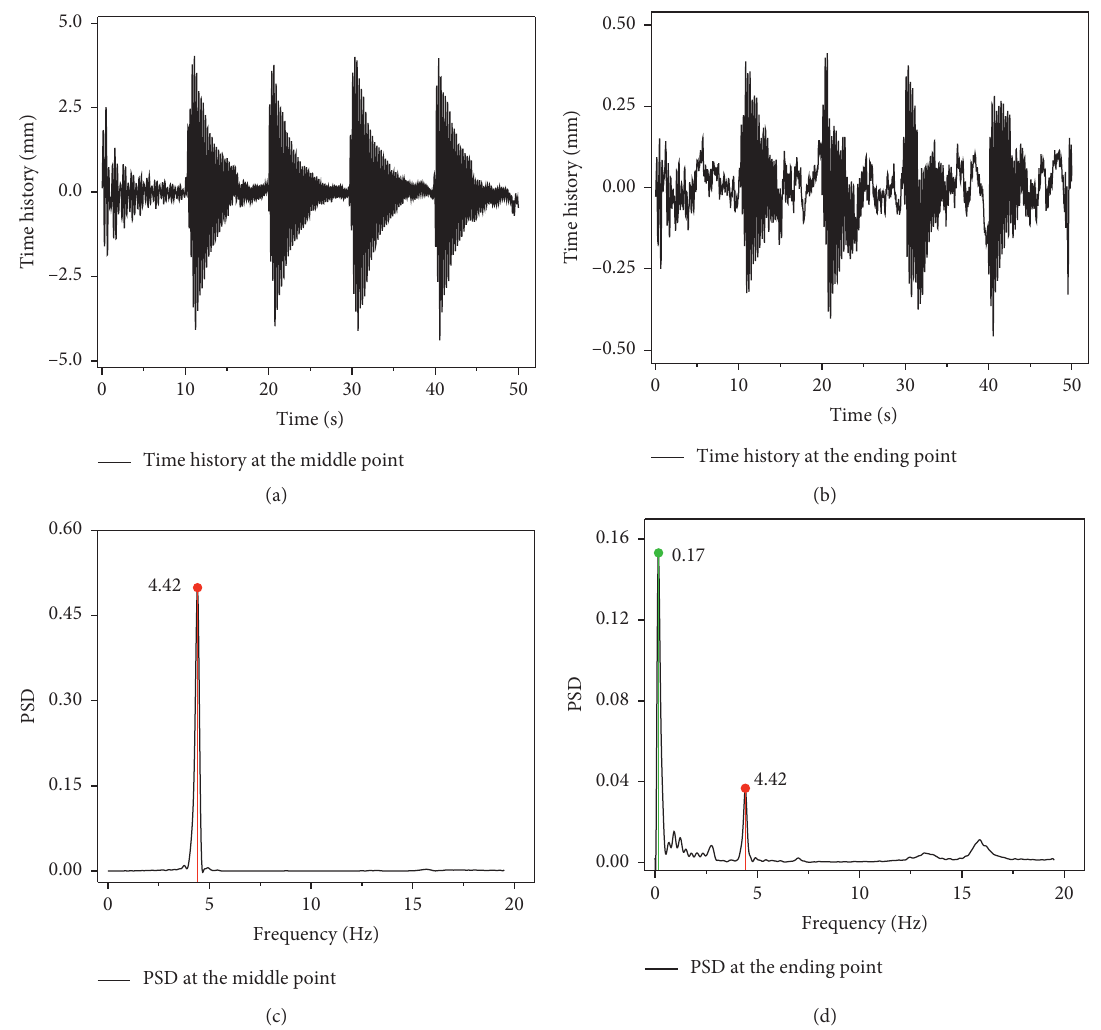
Figure 8: Analysis data by DIC obtained from the middle point and the ending